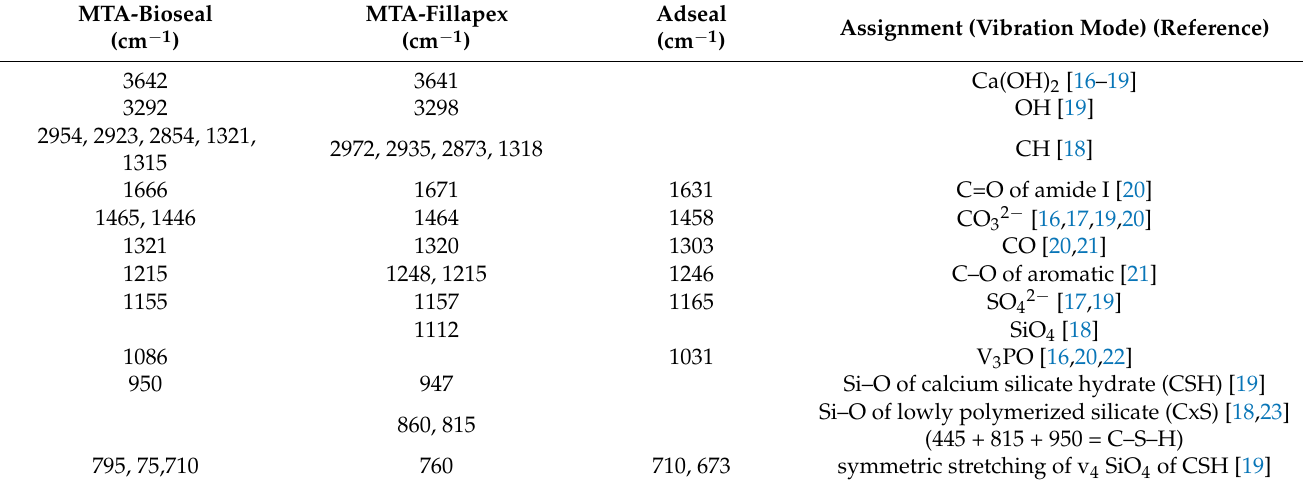
Table 1. Fourier transform infrared spectroscopy (FTIR) information of analyzed root canal